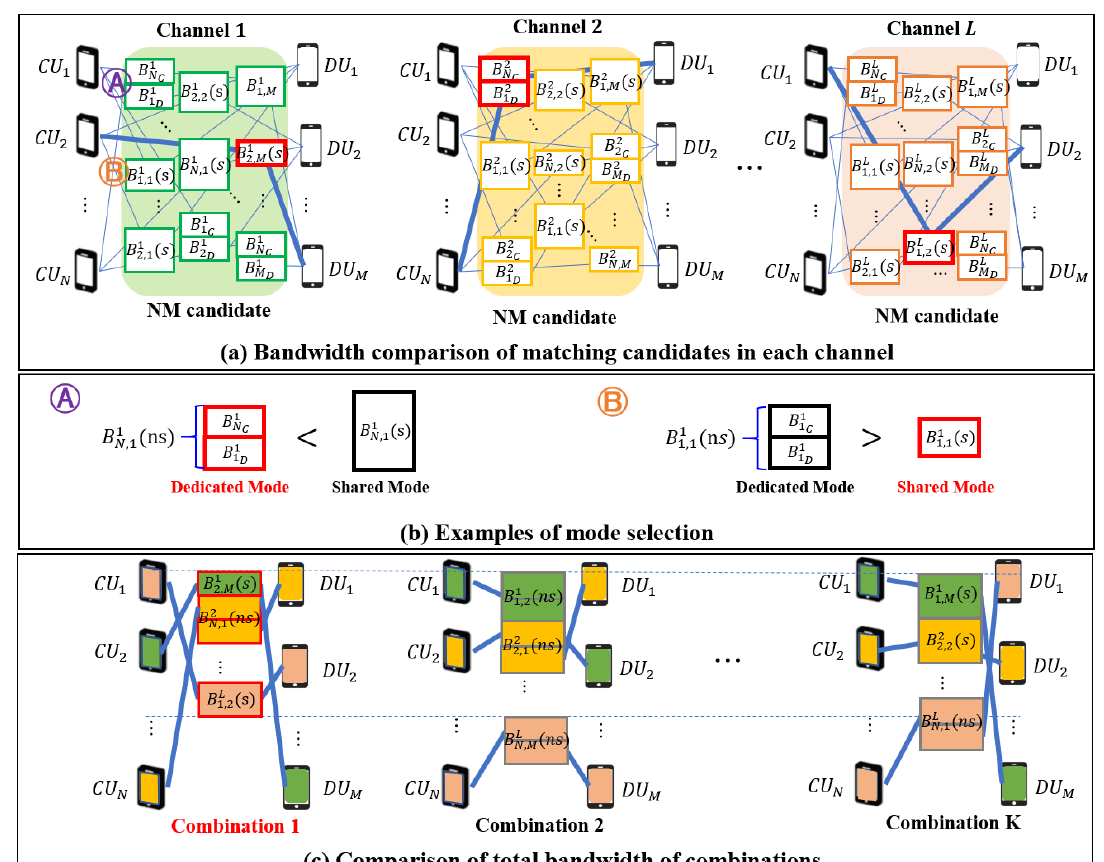
Figure 2. Channel bandwidth, channel sharing mode, and matching combinations.